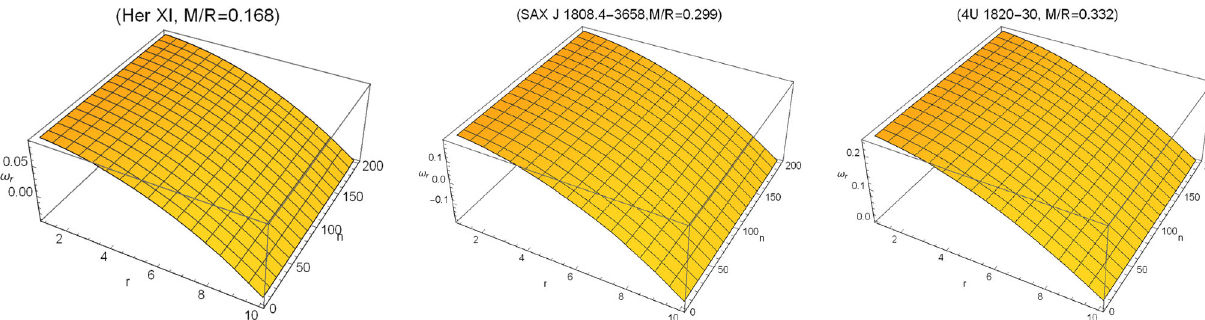
Fig. 1 Variation of EOS parameter ω r with radial coordinate r (km) and model parameter n